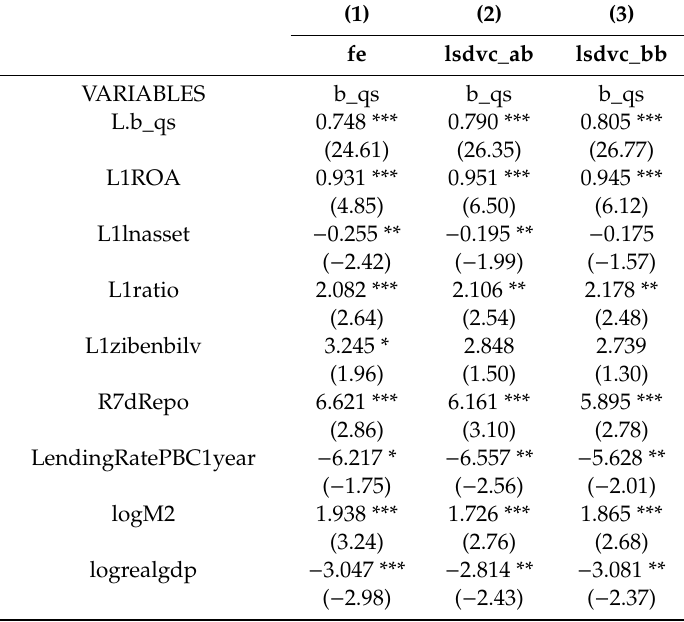
Table 8. Robustness test of Model